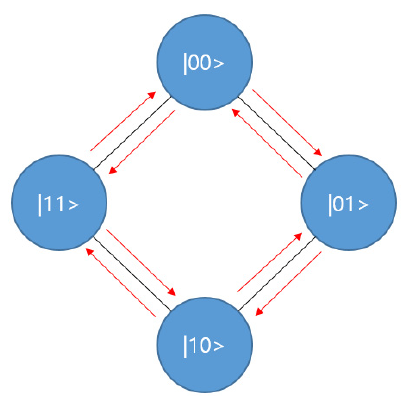
Figure 17. Quantum random walk on a circular graph.